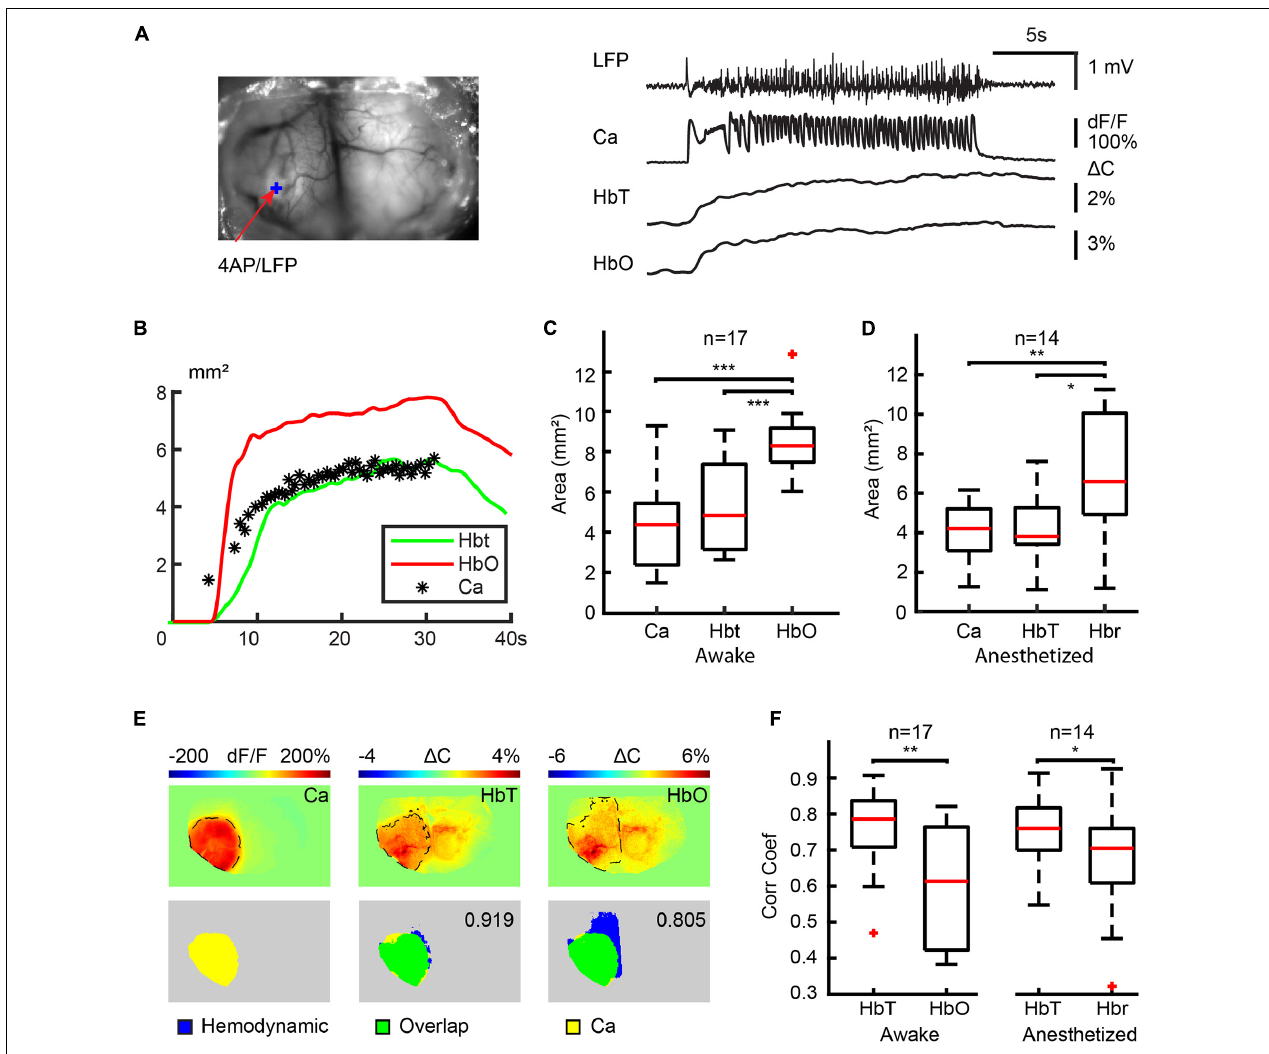
FIGURE 5 | Spatial correlation between calcium and hemodynamic signals in ipsilateral cortex. (A) The field of view and the traces of LFP, calcium, HbT, and HbO traces from the 4-AP injection site. (B) The area of change during the ictal event. Note: The areas of the HbT signal more accurately map the calcium area than the HbO signal. (C) Box plot of a maximal area of calcium, HbT, and HbO signals in awake mice. Note: The HbT and calcium areas are not significantly different. (D) Box plot of maximal calcium, HbT, and Hbr signal in anesthetized mice. Note: The HbT and calcium areas are not significantly different. (E) Example of the spatial overlap between maximal calcium and hemodynamic areas. The top rows show the maximal area of the different signals. The dashed black line indicates the maximal area in the ipsilateral cortex defined with a modified Chen-Bee method. Bottom row: the spatial overlap between maximal calcium and hemodynamic area. The 2D correlation coefficient between calcium and the hemodynamic area is labeled. (F) The boxplot of the correlation coefficient between calcium and hemodynamic areas in awake and anesthetized mice. *** p < 0.001, ** p < 0.01, and * p < 0.05.